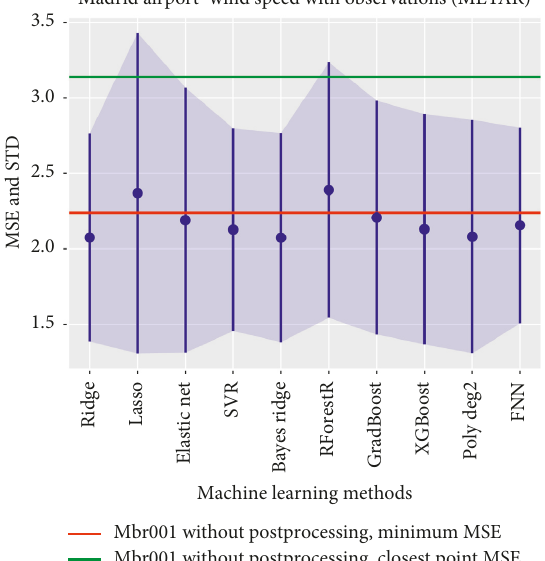
Figure 12:10 meters total wind calibration plot for Madrid airport. Horizontal axis, from left to right: ridge, lasso, elastic net, singular vector regression, Bayesian ridge, random forest regression, gra- dient boosting regression, XGBoost regression, polynomial of order 2, and feedforward neural network.